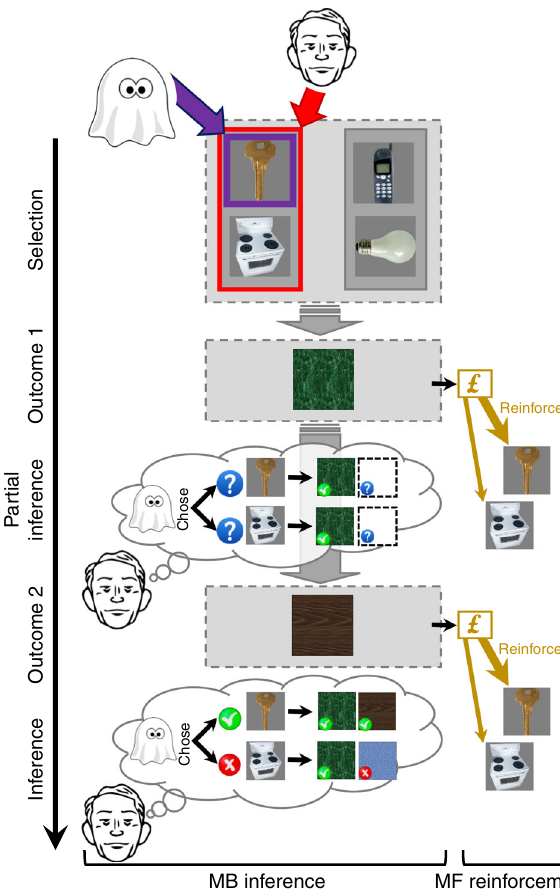
Fig. 3 MB retrospective inference and its effects on MF learning. After the agent choses an object pair (here, left), the ghost nominates randomly (and latently) one of the objects in this selected pair (here, top). The agent, therefore, has a 50 – 50% belief with respect to the ghost-nominated object. The posterior belief after observing the fi rst (green) outcome remains 50 – 50% since this outcome is common to both chosen-pair objects. The second (brown) outcome is unique to the ghost-nominated object and hence, a model of the transition structure allows for perfect inference on the ghost ’ s nomination. We probed different types of standard follow-up trials to examine how the MF system assigned credit to rewards that were obtained on the uncertainty trials. In the absence of any inference about the ghost ’ s nomination, learning should be equal in strength for both objects in the pair chosen by the subject. Supporting our retrospective-inference theory, we found that an MF assignment of credit received from the second outcome is mainly attributed to the ghost-nominated object (indicated by the thickness of the bottom “ reinforcement ” arrows). Strikingly, we also found that credit from the fi rst outcome was assigned to a larger extent to the ghost-nominated object (indicated by the thickness of the top “ reinforce ” arrows). Images adapted from the stimulus set of Kiani et al. 2007, ref.